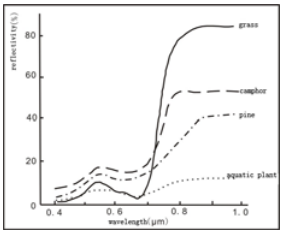
Figure 2. Spectral curve of aquatic and terrestrial